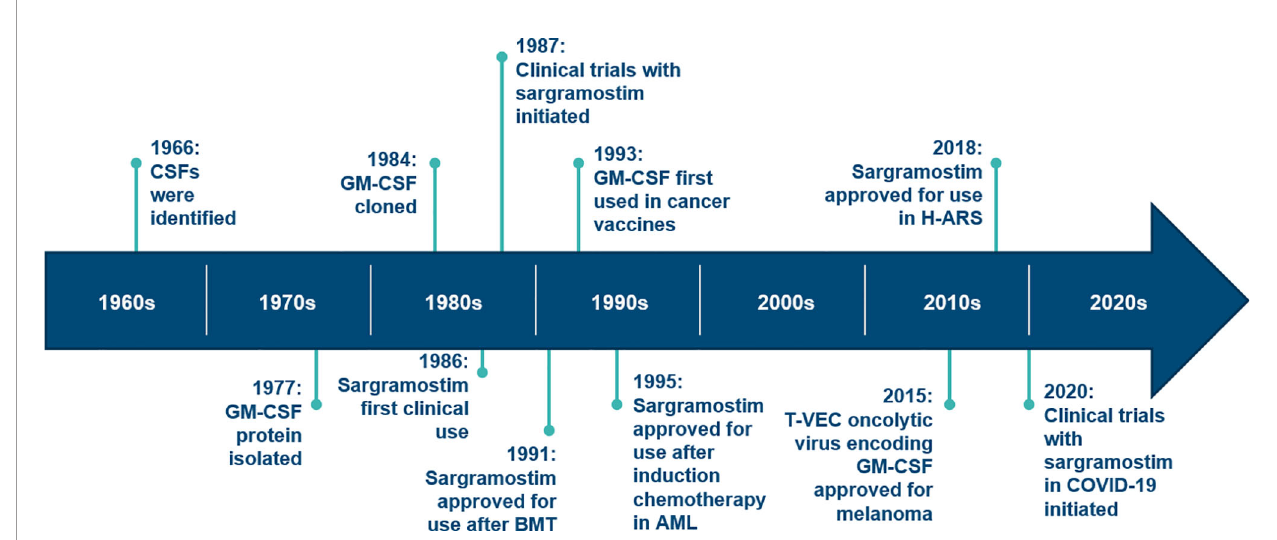
FIGURE 1 | Timeline for discovery and development of GM-CSF. AML, acute myeloid leukemia; BMT, bone marrow transplant; CSF, colony-stimulating factor; GM- CSF, granulocyte-macrophage colony-stimulating factor; H-ARS, hematopoietic acute radiation syndrome; T-VEC, talimogene laherparepvec. (Modi fi ed from: Dougan M, Dranoff G, Dougan SK. GM-CSF, IL-3, and IL-5 family of cytokines: Regulators of In fl ammation. Immunity. 2019;50(4):796 ‐